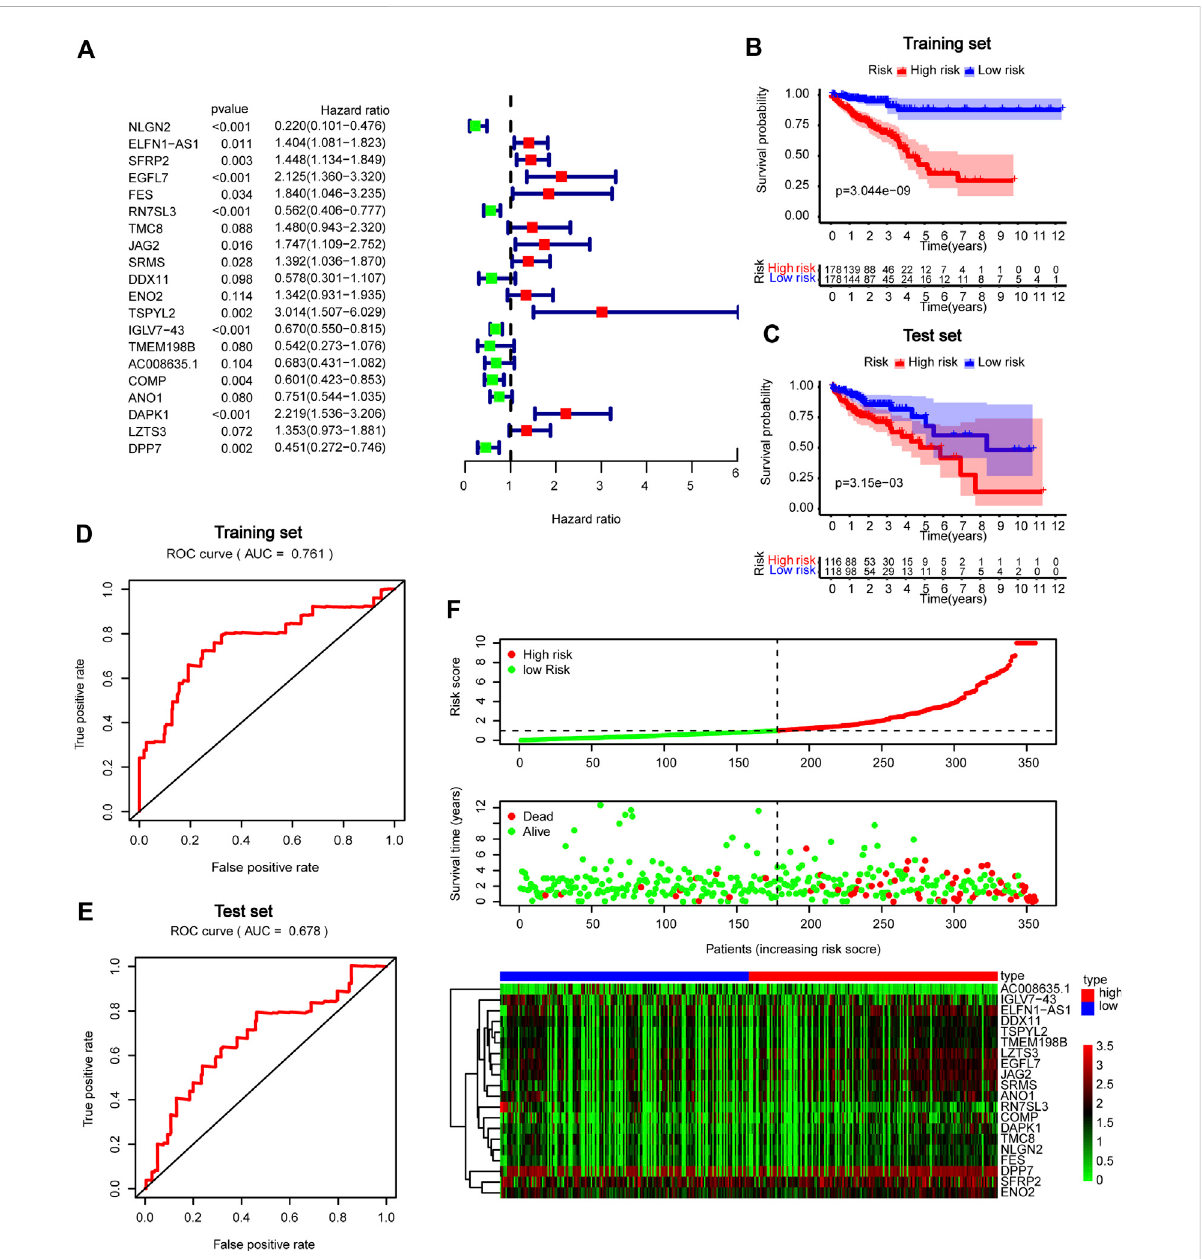
FIGURE 8 Constructionand validation ofGBP5 related prognostic models inCRC (A) Forestplotinmultivariate Coxanalysis. (B,C) Kaplan-Meier curves of high- and low-risk score groups in training and test sets (D,E) ROC curves in training and test sets. (F) Risk plot of high- and low-risk score groups.